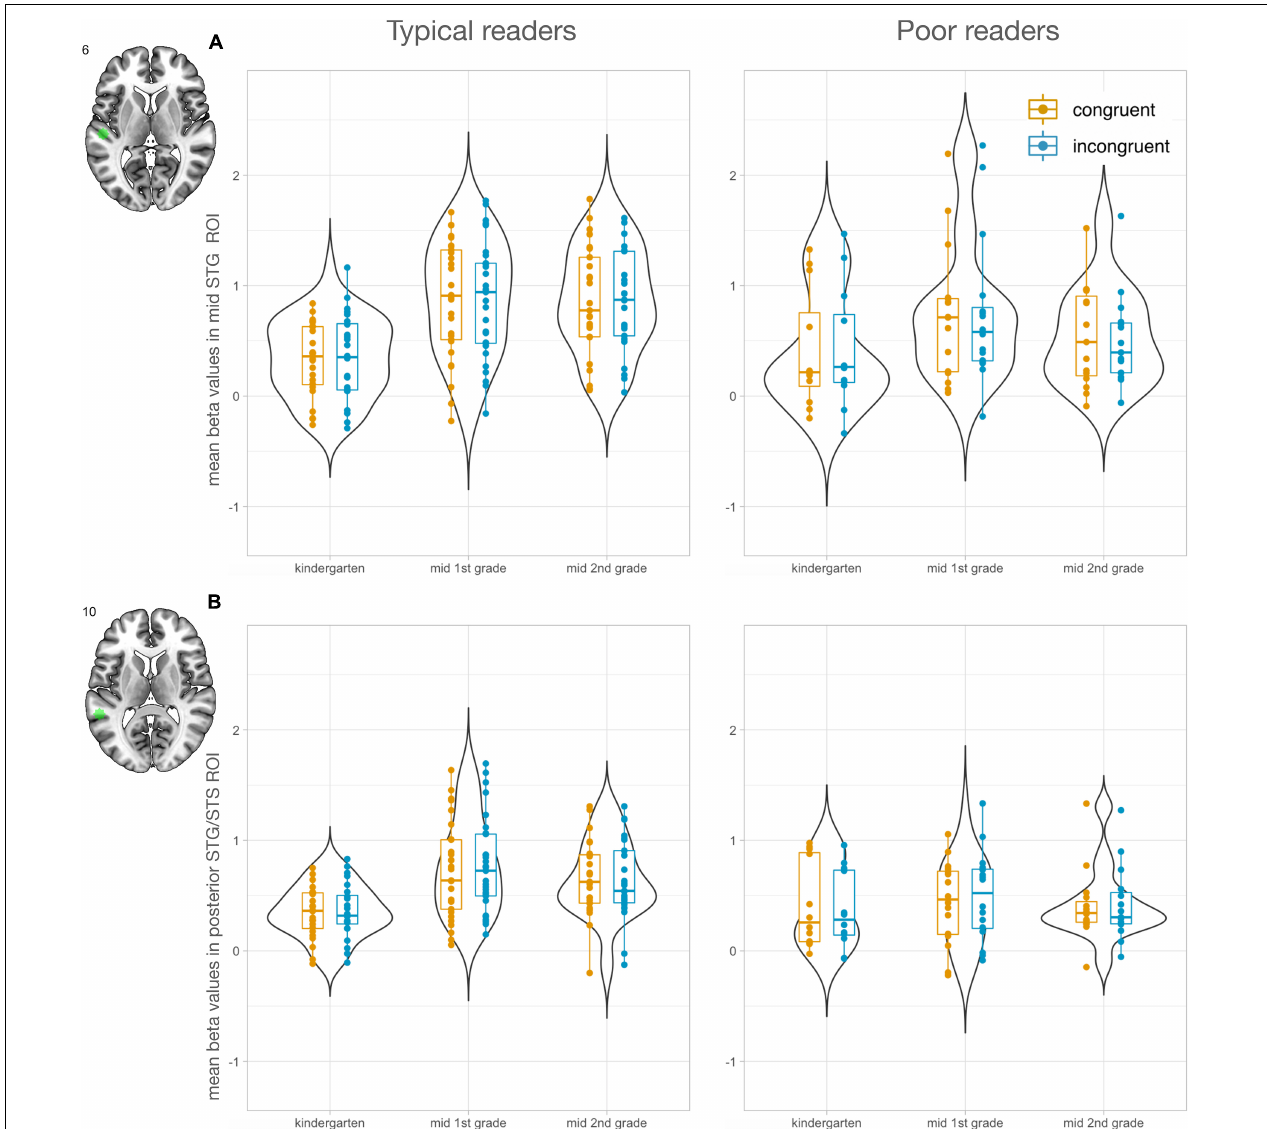
FIGURE 3 | Region of interest analyses in audiovisual processing areas of the STG ( n = 47). Mean beta values in STG ROIs increased from kindergarten (T1) to 1st grade (T2) and second grade (T3) in the typical reading group. (A) Mid STG ROI (midSTG). (B) Posterior STG ROI (postSTG). Left panels show values for typical readers and right panels for poor readers. Mean responses to congruent letter-speech sound pairs are shown in orange and to incongruent in